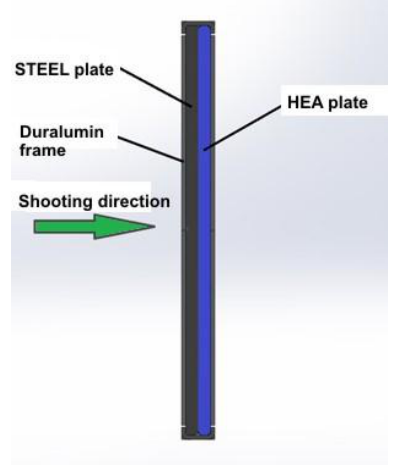
Figure 10. The shooting scheme for structure 2.